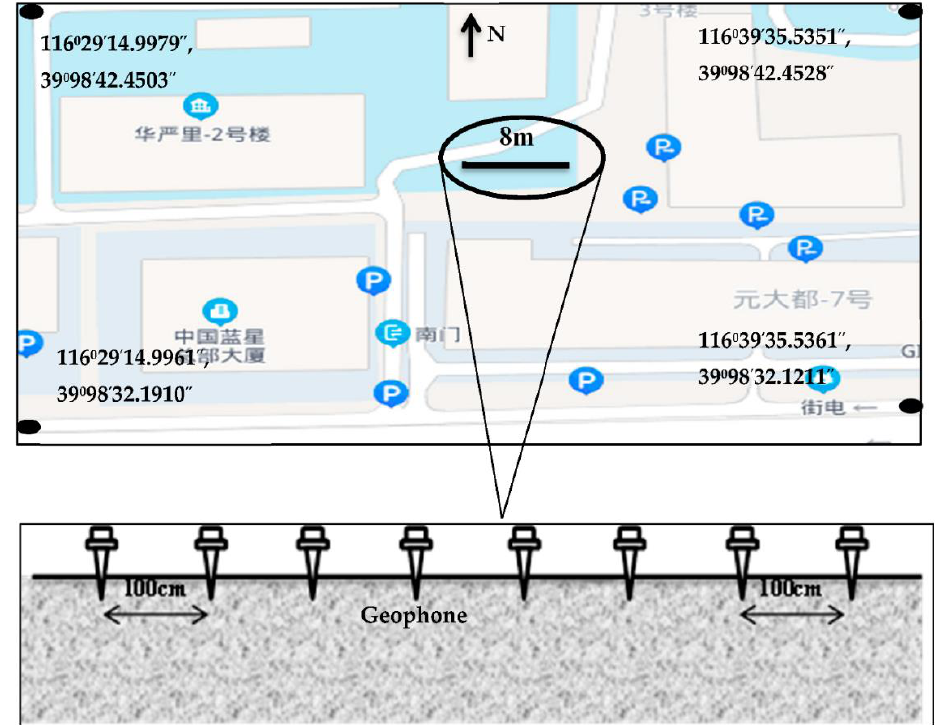
Figure 6. Field testing of the proposed multichannel seismograph. A single traverse of 8 m spread was used for seismic wave tomography. Each geophone was planted vertically with an offset of 1 m from its neighbors.